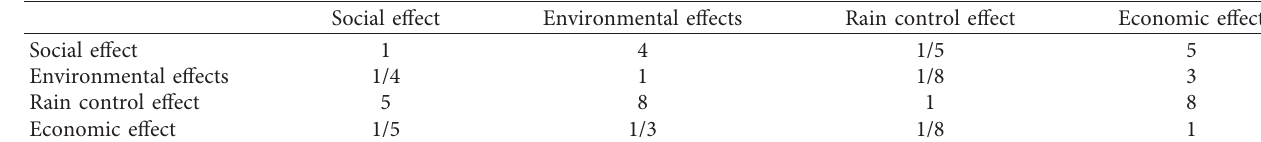
Table 9: Standard level index scale